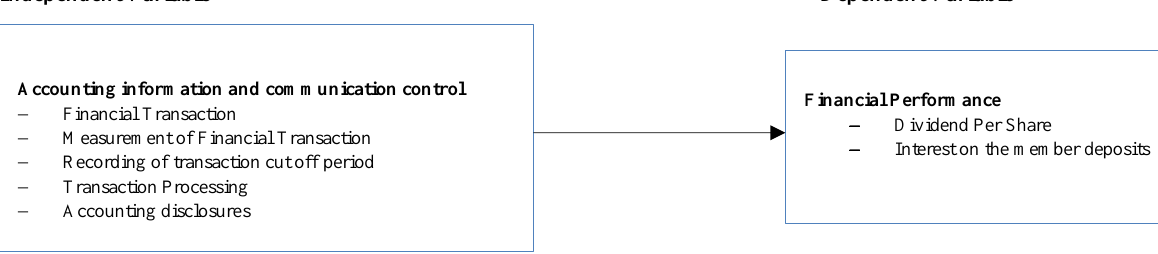
Figure 1: Conceptual